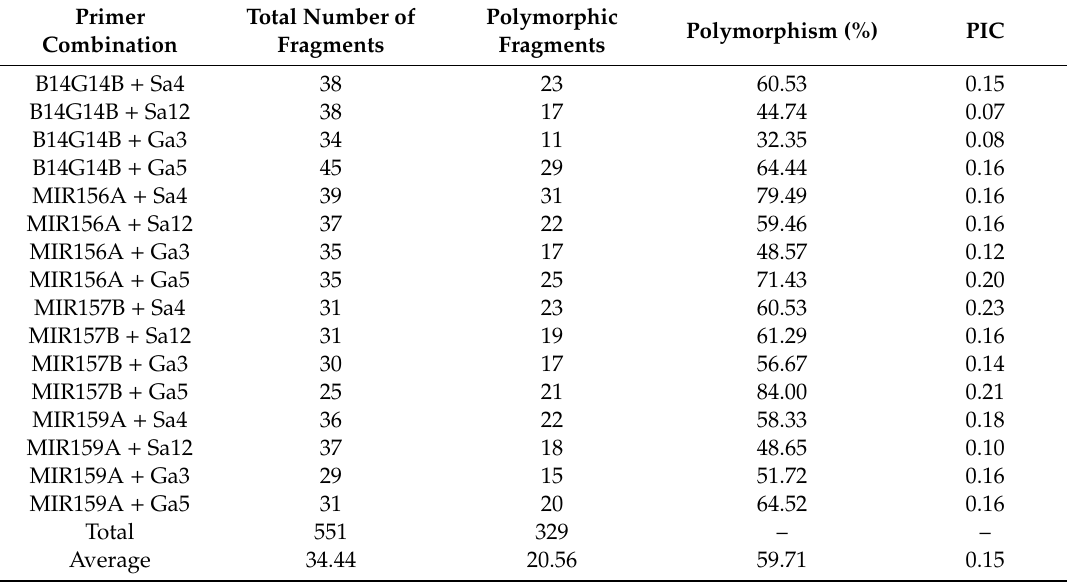
Table 4. Summary of polymorphism of 16 TRAP marker sets in 208 soybean MDP